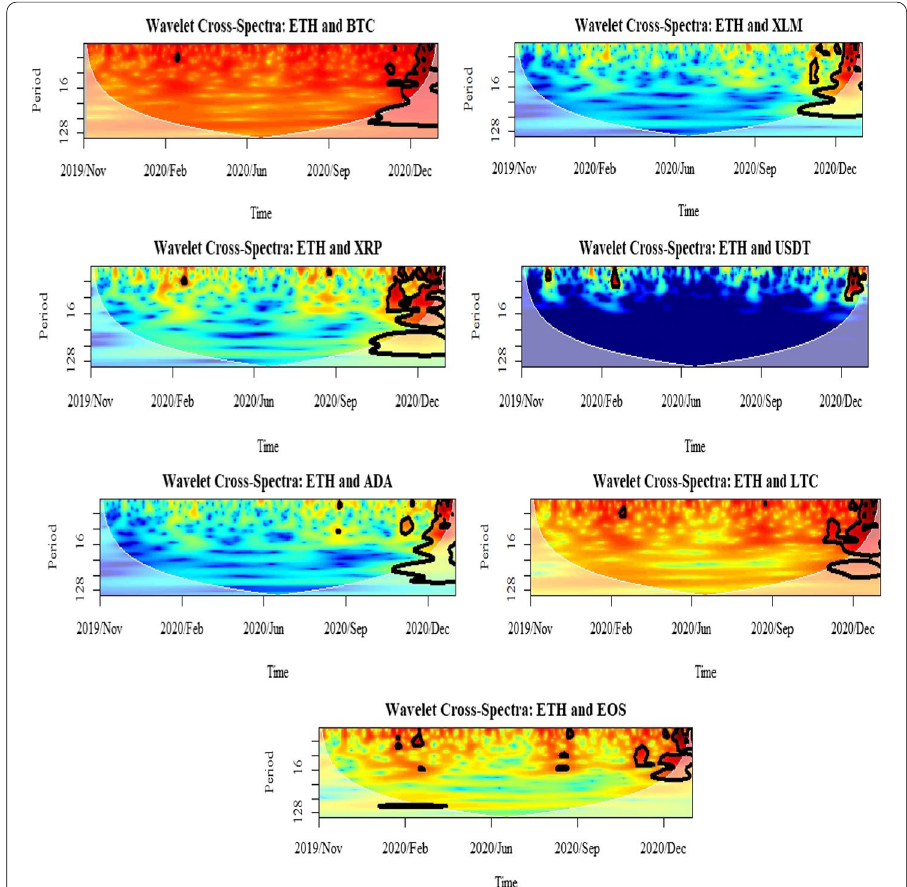
Fig. 10 Results for wavelet cross-spectra: ETH